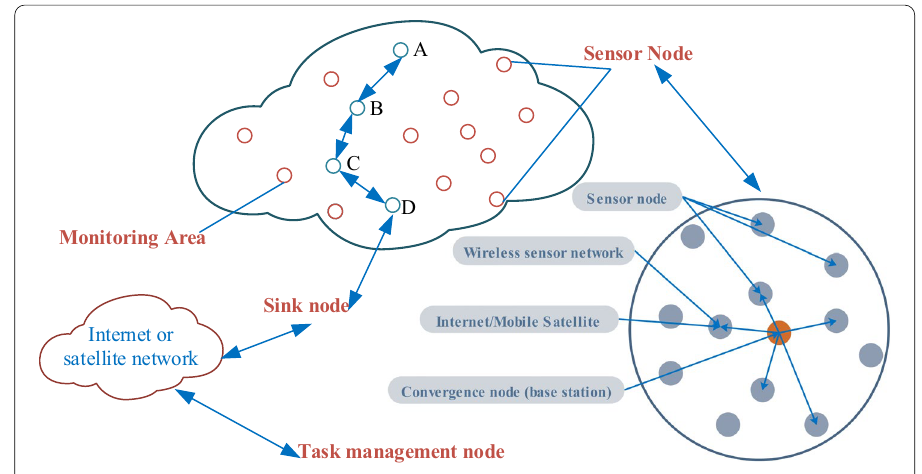
Fig. 2 Typical architecture of wireless sensor